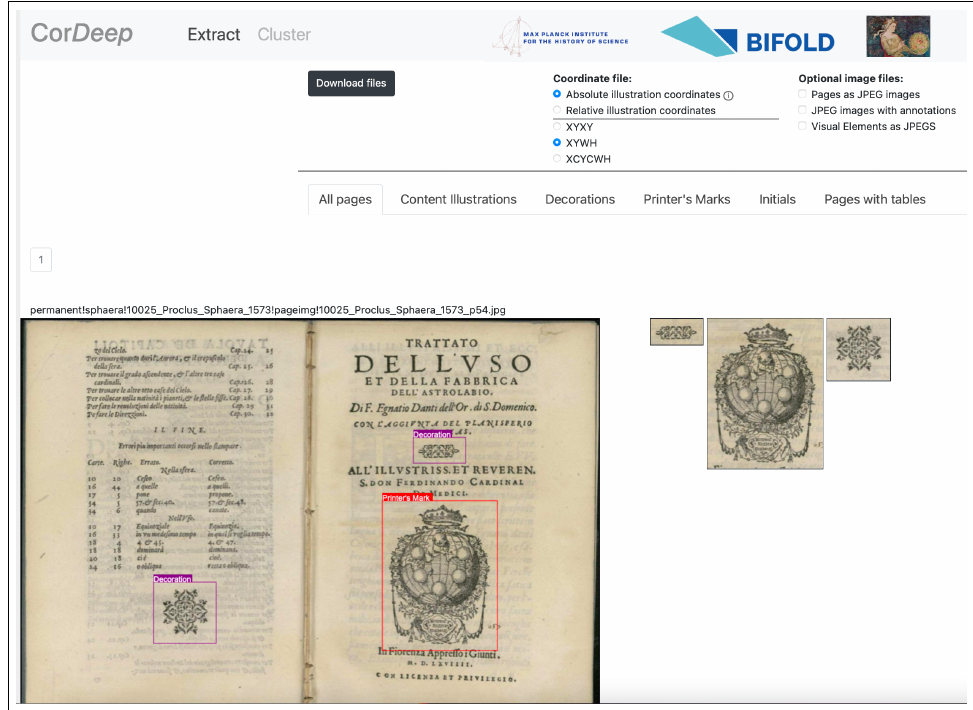
Figure 6. Screenshot of the web application Cor Deep depicting the visualization of detected material by the